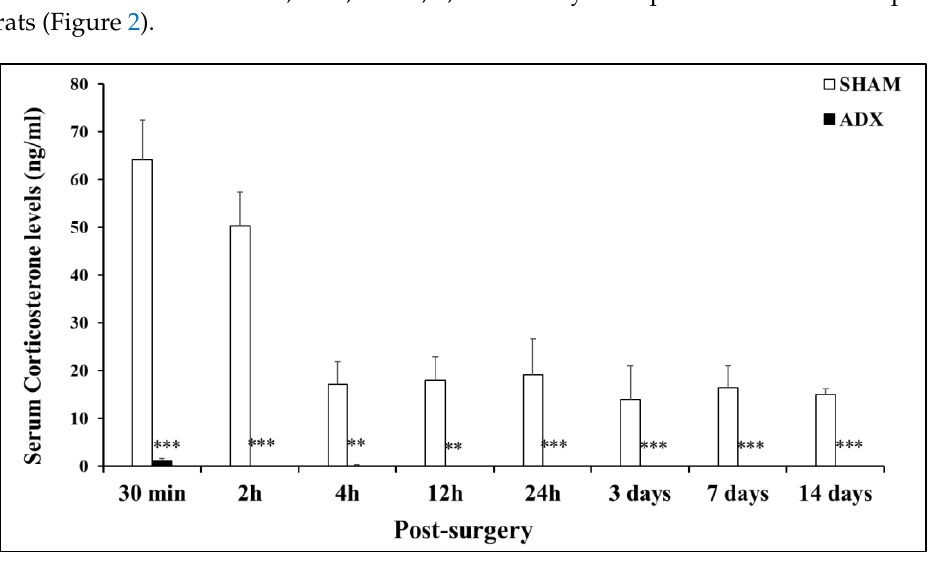
Figure 2. Bar graph showing the levels of serum corticosterone (CORT). Levels of CORT in the serum of ADX rats and SHAM operated rats were measured by Enzyme Immunoassay (EIA) to assess the efficacy of adrenalectomy (n = 204) over the course of time (30 min, 2 h, 4 h, 12 h, 24 h and 3, 7,